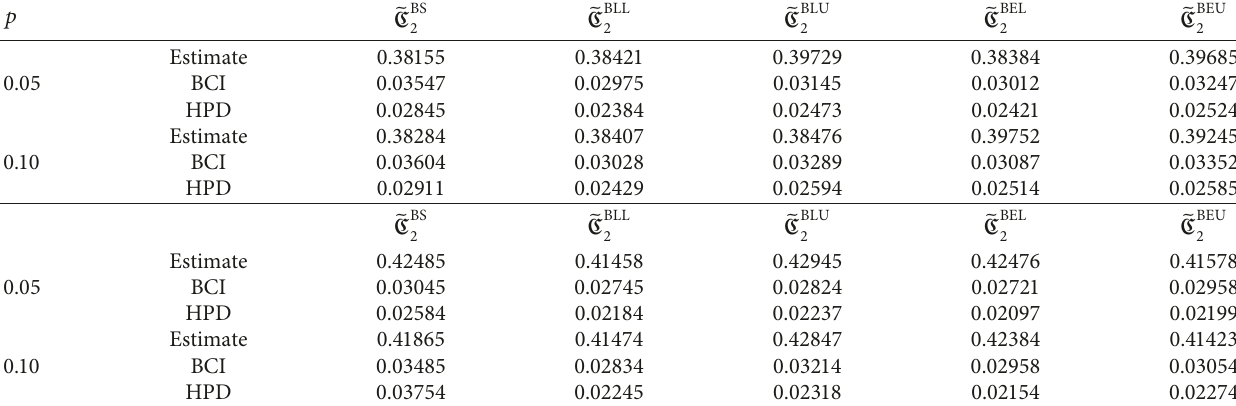
Table 22: Bayes estimate of parameter and parametric function with their confidence